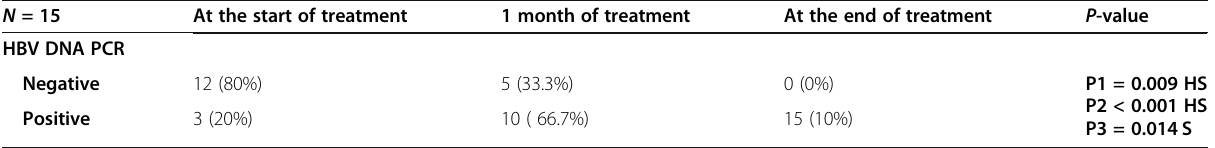
Table 7 Comparison between HBV DNA PCR results in the studied patients N = 15 At the start of